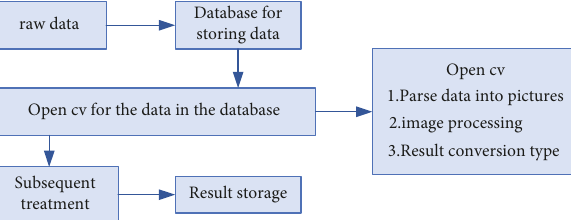
Figure 2: Combined design flow chart of image data